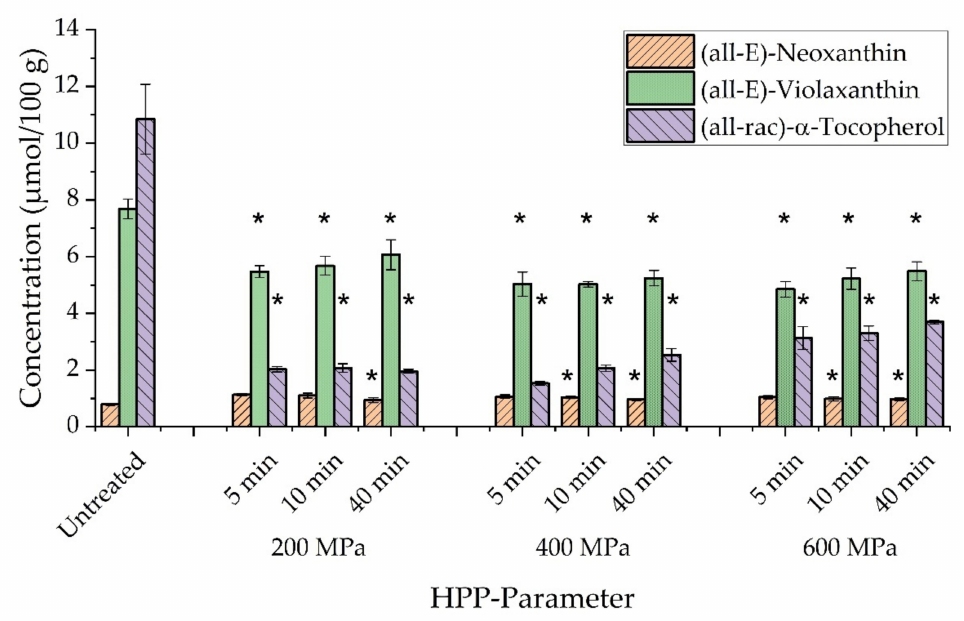
Figure 3. Concentrations of (all-E)-neoxanthin, (all-E)-violaxanthin, and (all-rac)- α -tocopherol in untreated and HP-treated kale in dependence on high-pressure processing (HPP) parameters (200–600 MPa with holding periods of 5 min, 10 min, and 40 min). Untreated kale represents raw, crushed kale samples, without HP-treatment. One-way ANOVA with Tukey-HSD post hoc test; aster- isks in the same line indicate significant differences ( p < 0.05) between treated and untreated samples. Similar trends could be observed regarding (all-E)-violaxanthin, considering a signifi- cant decrease of up to 37%, compared to untreated kale including a decrease of 15% caused by transport. Slightly increasing, but non-significant changes in concentration of (all-E)- violaxanthin were again obtained for elevated pressure rates and extended holding